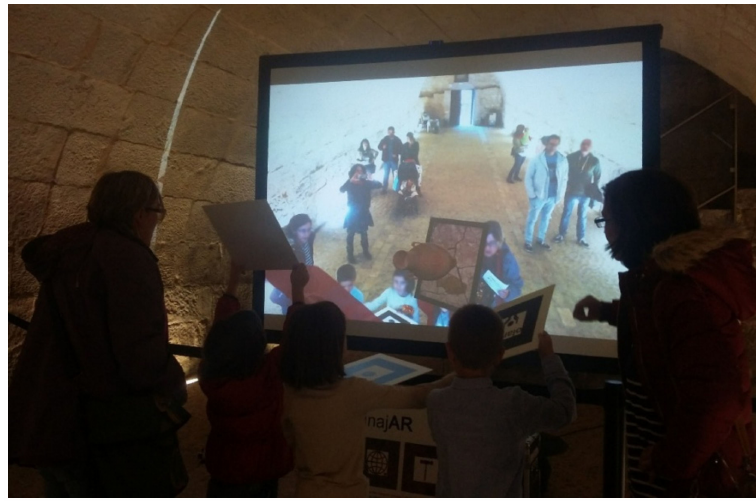
Figure 10. Children enjoying TinajAR in Logroño, Spain.